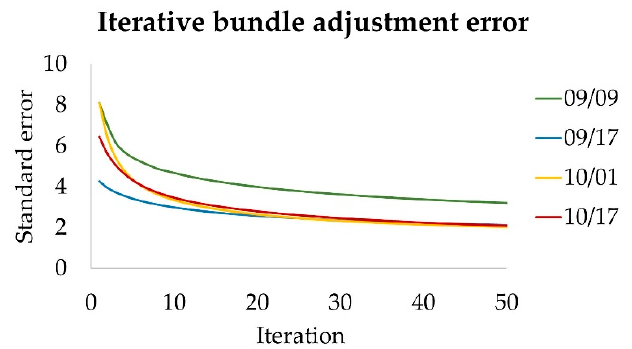
Figure 8. Fusion error convergence with iterations (in pixels) on four defoliating dates in 2018.